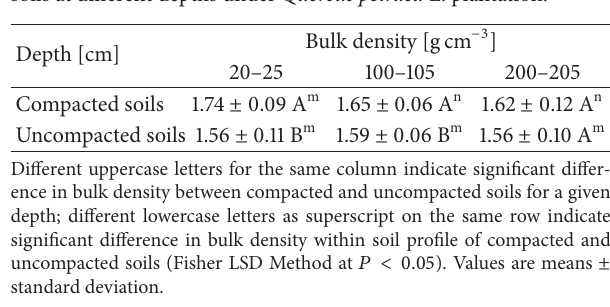
Table 1: Bulk density of compacted and uncompacted postmining soils at different depths under Quercus petraea L.